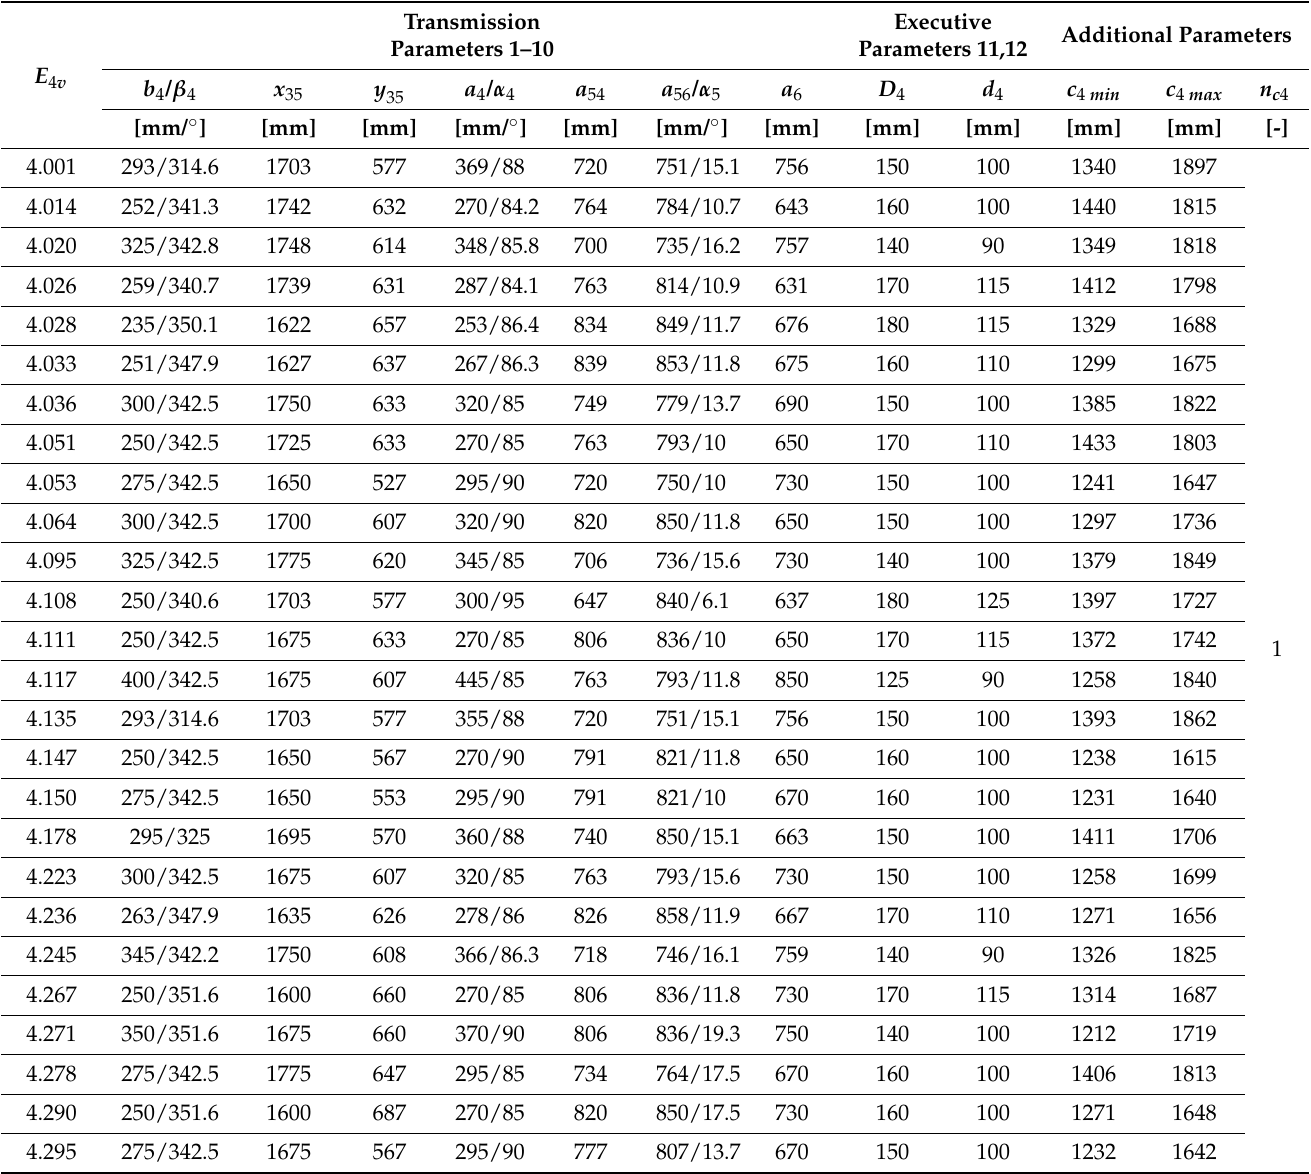
Table 2. Variant solutions for the bucket drive